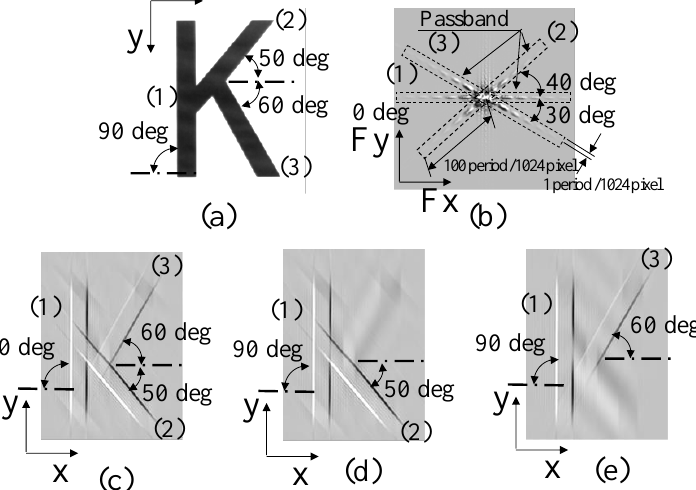
Figure 10. Filters for extracting shape of alphabet character “K”. ( a ) Shape of alphabet character “K”; ( b ) Shape information and passband of each filter in frequency domain; ( c ) Character image reconstructed by all parts using each filter; ( d ) Character image reconstructed by (1) and (2) parts using each filter; ( e ) Character image reconstructed by (1) and (3) parts using each